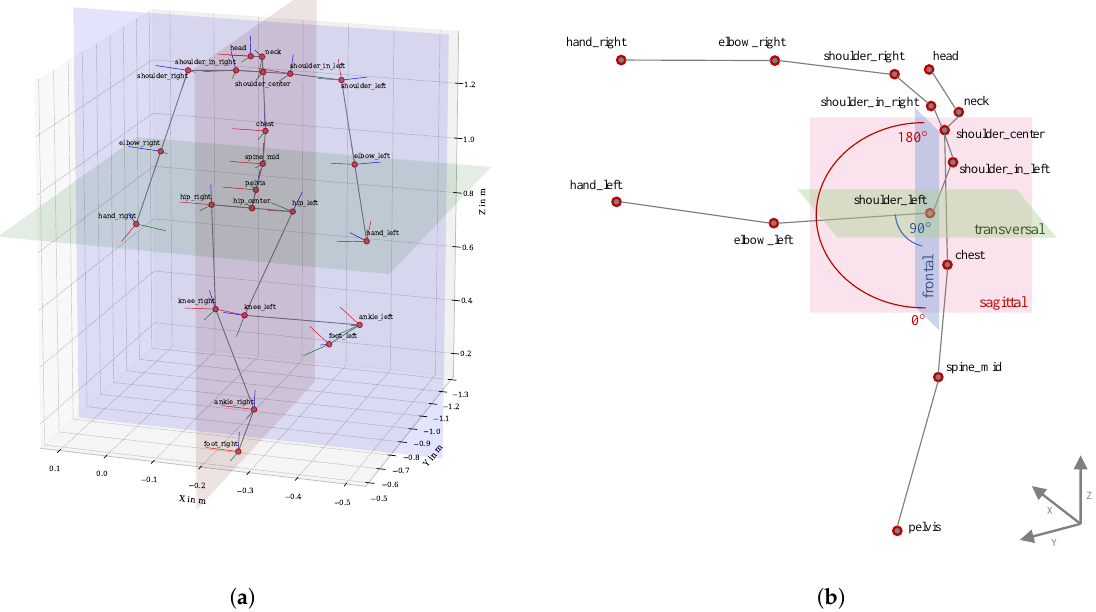
Figure 4. Method for calculating joint angles. ( a ) Kinematic data (positions and local coordinate systems based on quaternions) from body posture when standing on one leg while the right hand rotates. Globally plotted body planes: frontal in blue, sagittal in red and transversal in green. ( b ) An example of the calculation of the left shoulder’s elevation ( shoulder_left_elev ). The body planes are set locally to the shoulder_left position and orientated using shoulder_center and chest . The elevation angle is calculated with the frontal plane and moves in the sagittal